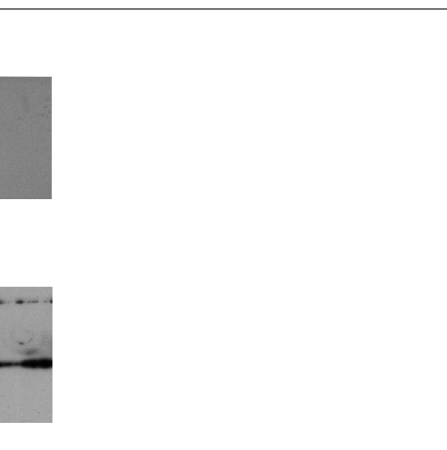
Figure 4. Dot blots of the two a -Syn-nAbs standard preparations of one IvIG batch and the affinity chromatography flow-through showing the specific binding of the purified antibody to recombinant a - Syn in different dilutions.